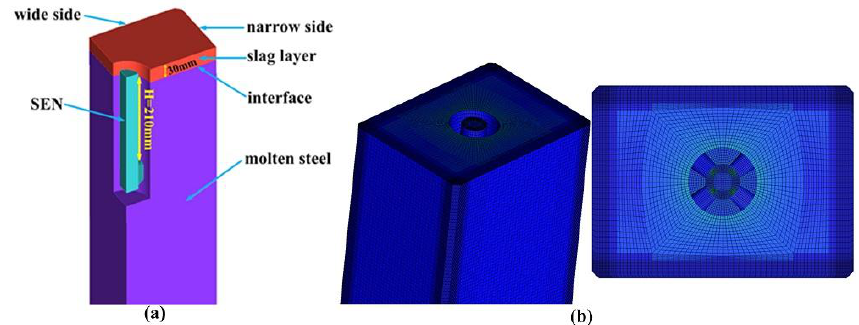
Figure 4. The schematic sketch of mold and meshed model of computational domain. ( a ) mold top part; ( b ) meshed